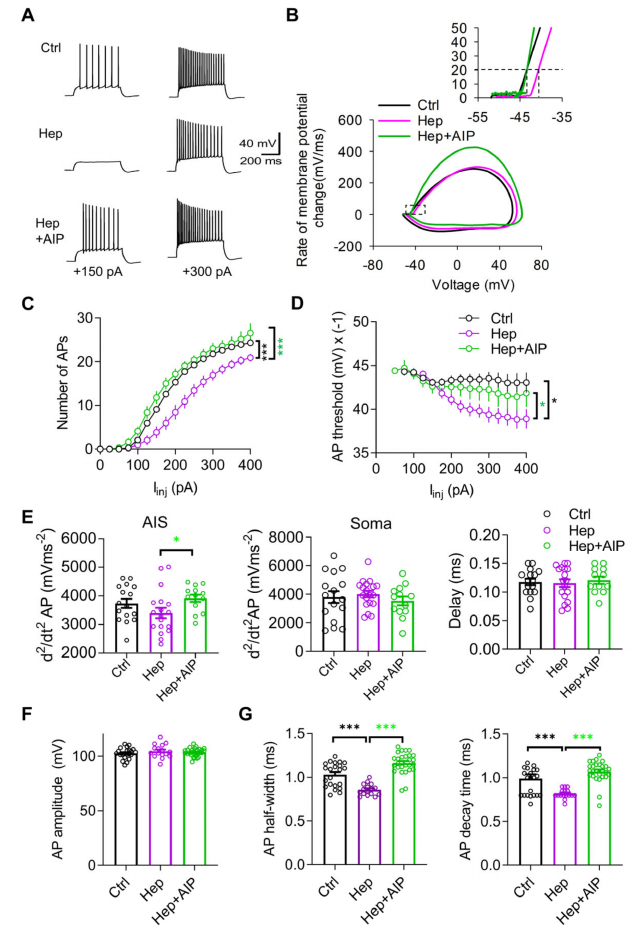
Figure 3. CaMKII inhibitor (AIP) could rescue reduced neuronal excitability of CA1